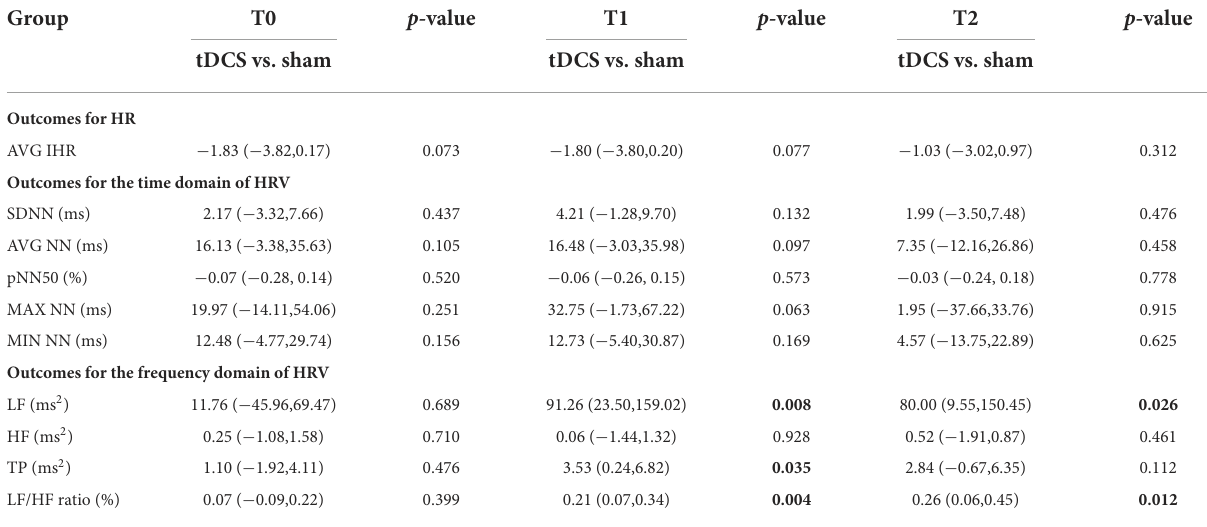
TABLE 2 Comparison of the duration and frequency of heart-rate variability with different interventions and at different points. Between–intervention differences at different points. estimate (95% CI)